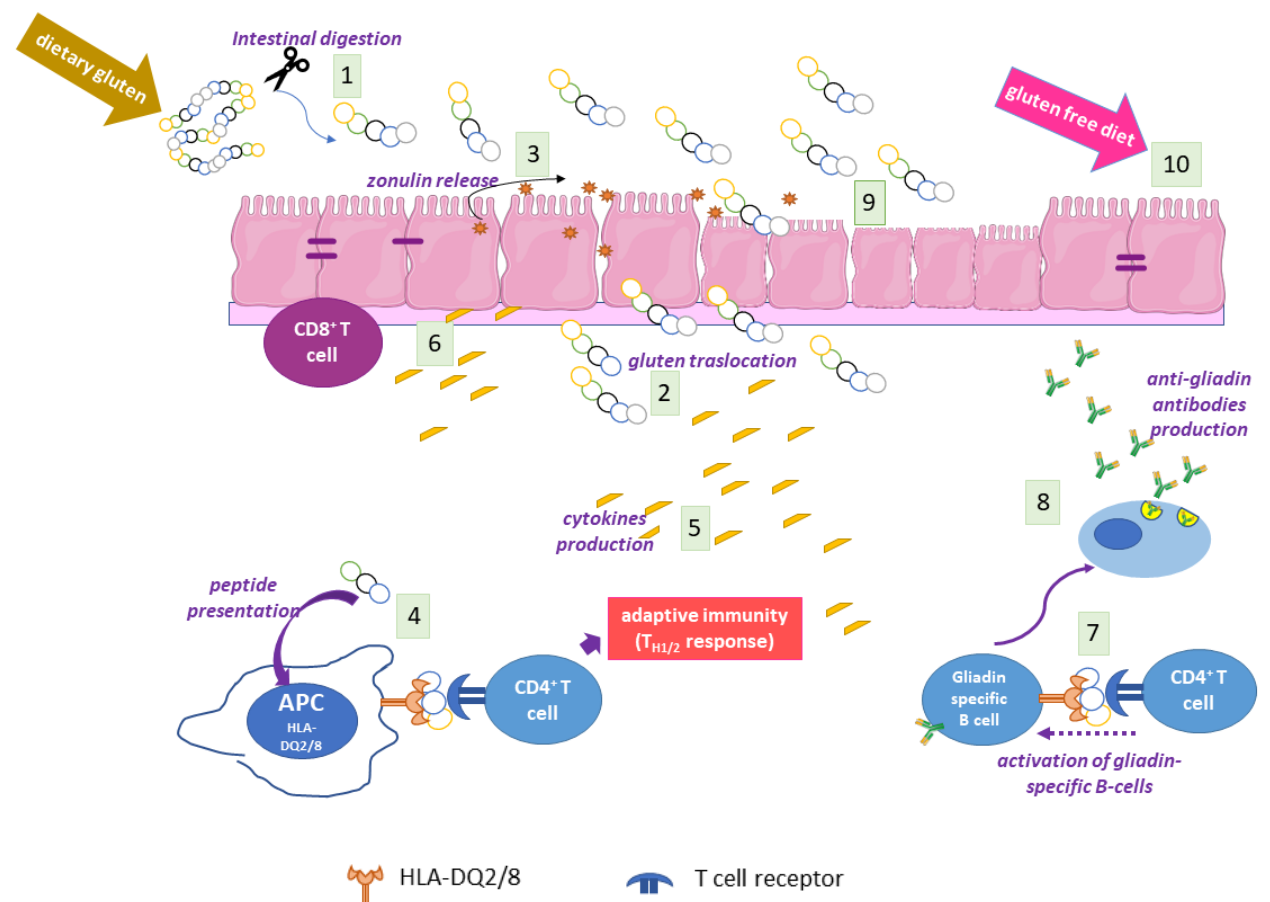
Figure 1 . Scheme of the main events of CD pathogenesis. In gut lumen, gluten/gliadin is partially digested ( 1 ) and large fragments cross the intestinal barrier ( 2 ), triggering an increased intestinal permeability with zonulin release ( 3 ). Antigen presentation by HLA-DQ2/8 APCs ( 4 ) elicits an adaptive immune response with the release of pro-inflammatory cytokines ( 5 ), the recruitment of cytotoxic T cells ( 6 ), and the activation of gliadin-specific B cells ( 7 ), with the consequent production of anti-gliadin antibodies ( 8 ). All together, these events lead to the loss of mucosal integrity ( 9 ), which is slowly recovered with a gluten-free diet ( 10 ). This scheme does not show the role of TG2 gluten modifications, which are explained in the next figures.